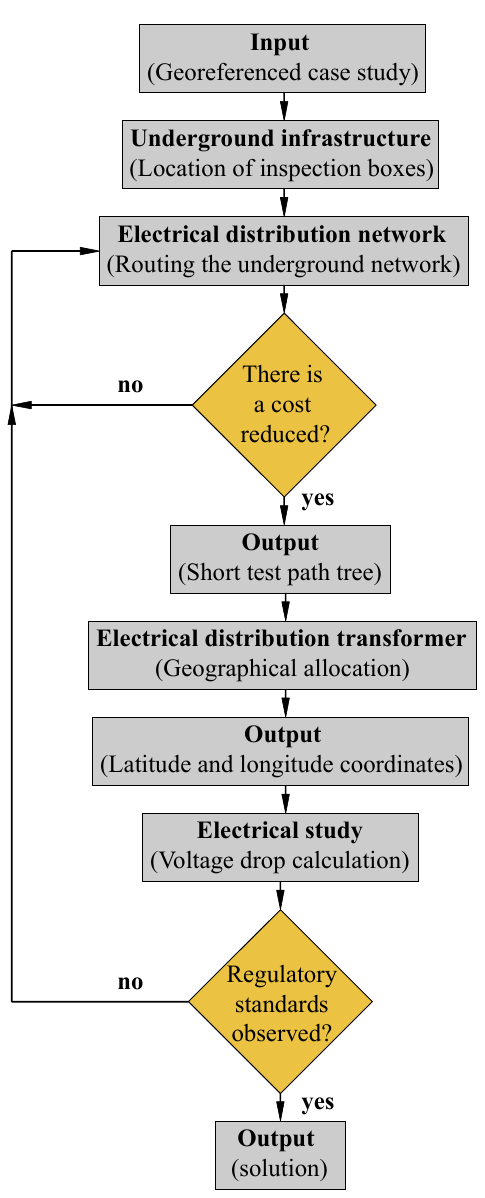
Figure 2. Underground power grid deployment